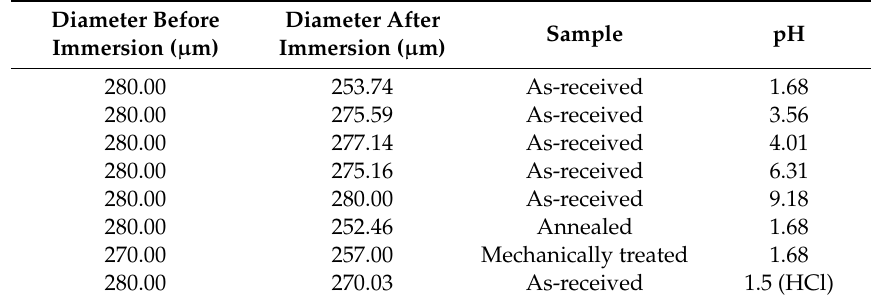
Table 3. Diameters of each type of NiTi wire sample before and after immersion for two years in solutions with various pH